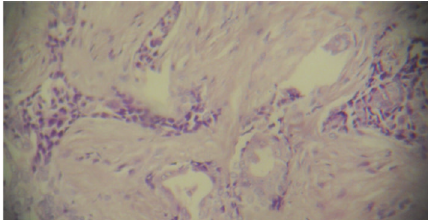
Figure 3: Histopathological picture showing odontogenic epithelial